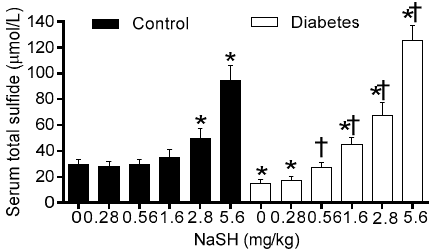
Figure 1. Effect of NaSH on serum total sulfide levels in control and diabetic rats. Rats were treated daily with different concentrations of NaSH for 9 weeks. Results are mean ± SEM (n = 10/group). * p < 0.05 compared to non-treated control rats, † p < 0.05 compared to non-treated diabetic rats.